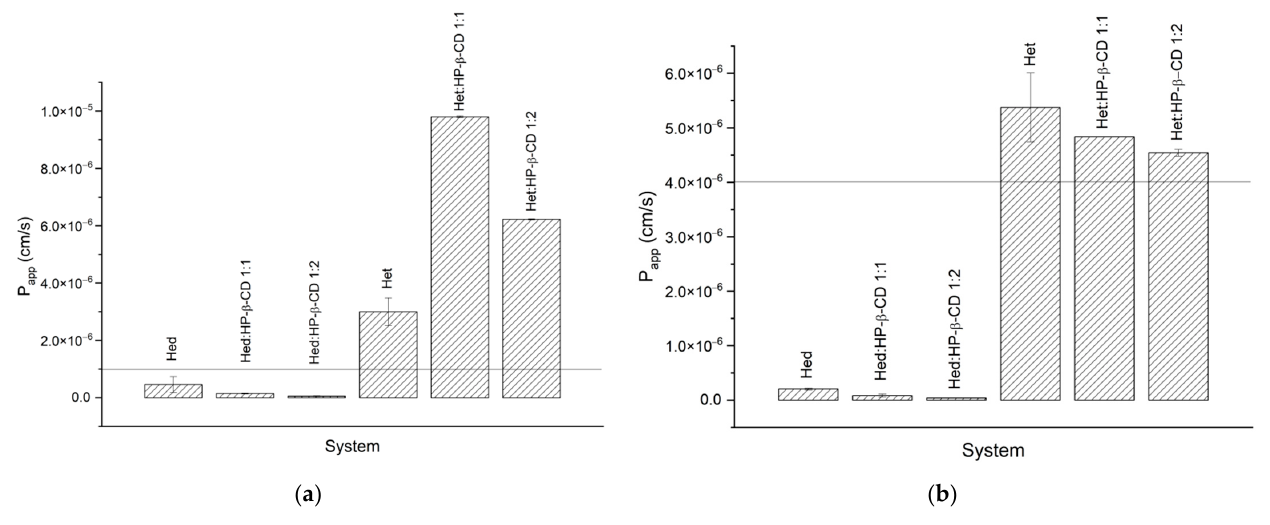
Figure 6. The results of PAMPA ( a ) GIT and ( b ) BBB assays.